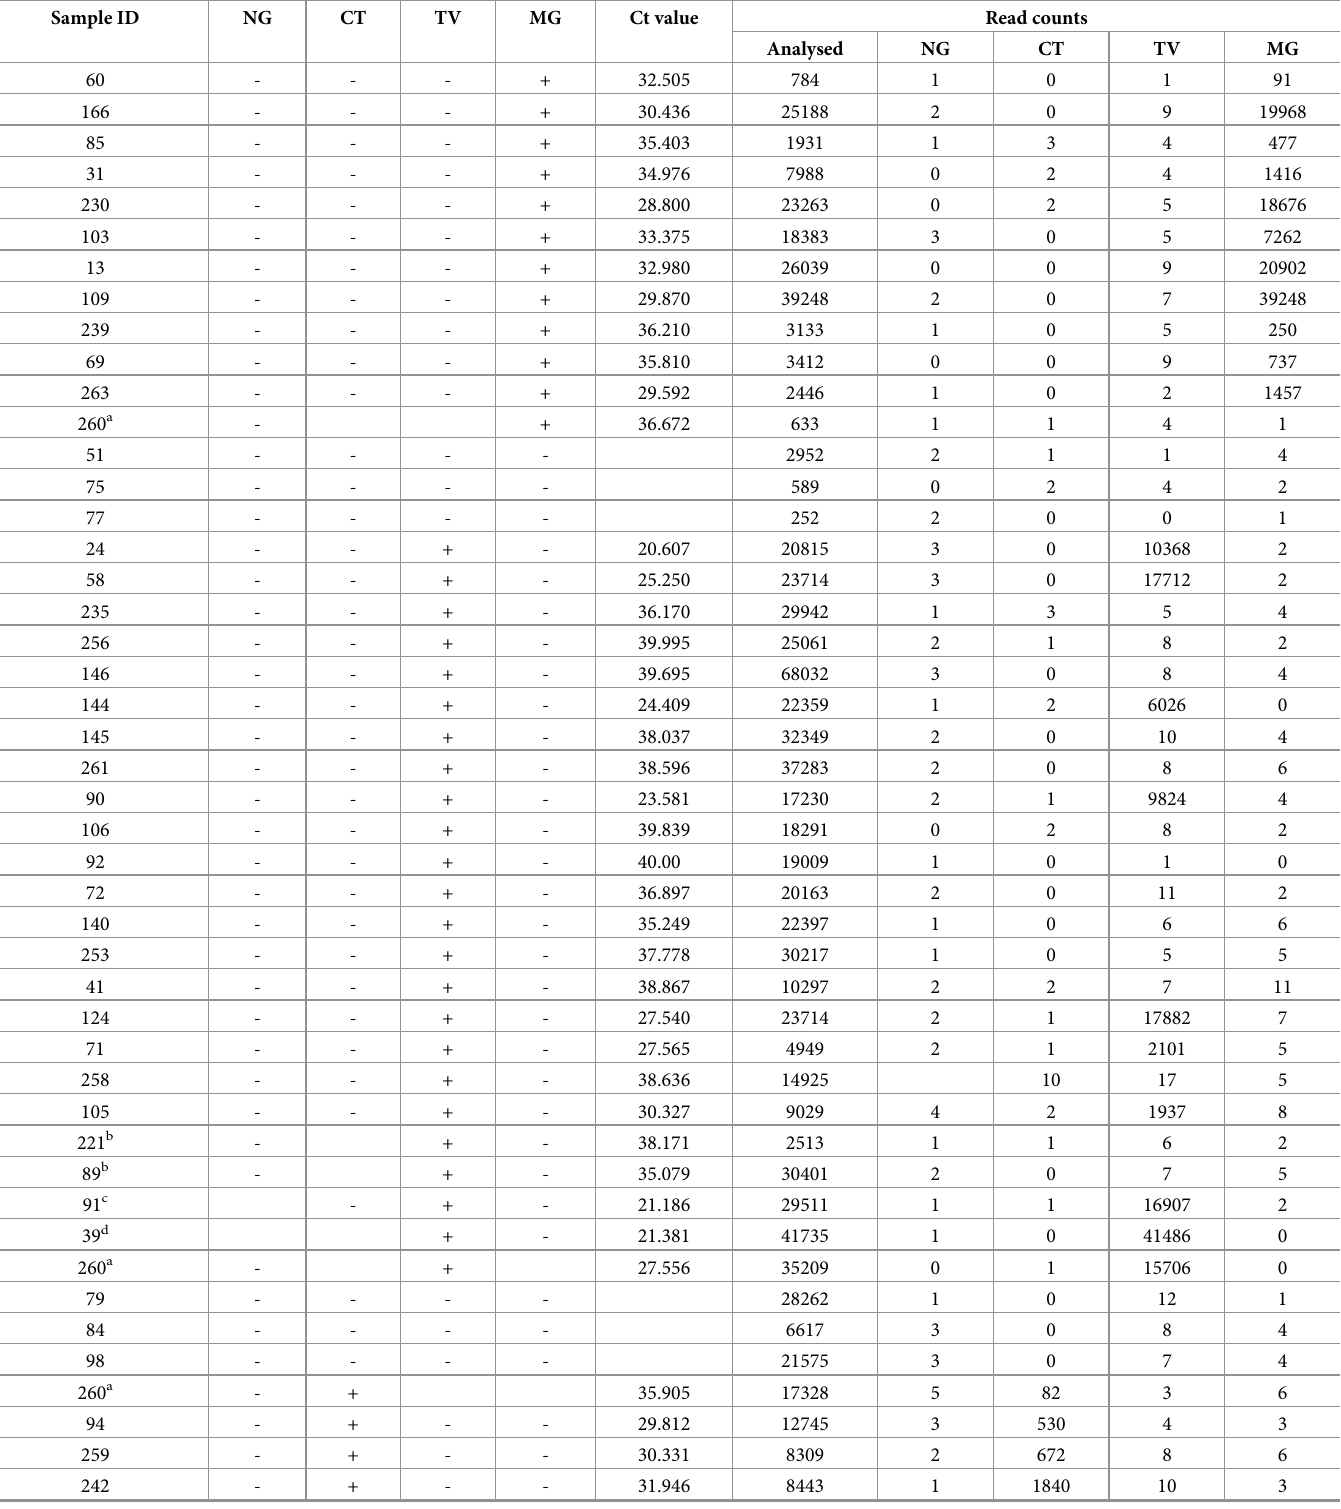
Table 2. STI identification of swab samples by qPCR and nanopore